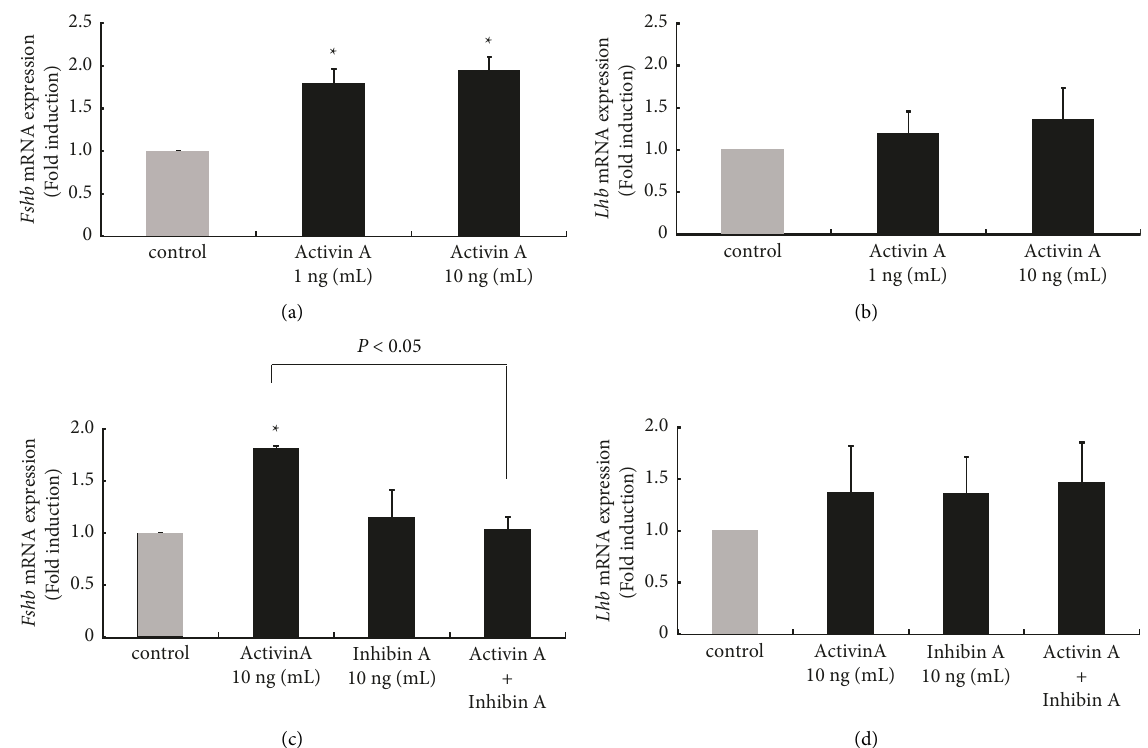
Figure 7: Effect of activin A and inhibin A on gene expression of gonadotropin subunits in gonadotroph L β T2 cells. L β T2 cells were stimulated with the indicated concentrations of activin (a) inhibin (b) or together with activin A and inhibin B for 24h After stimulation, mRNA was extracted and reverse transcribed, and mRNA levels of Fshb (A, C) and Lhb (B, D) subunit genes were measured by quantitative RT-PCR. Samples from each experimental group were run in duplicate and normalized to the mRNA levels of the housekeeping gene Gapdh. The results are expressed as fold induction over unstimulated cells and are presented as the mean ± SEM of three independent experiments. ∗ P < 0 . 05 versus the control. The difference between activin A and activin A + inhibin A on Fshb mRNA was statistically different ( P < 0 . 05).